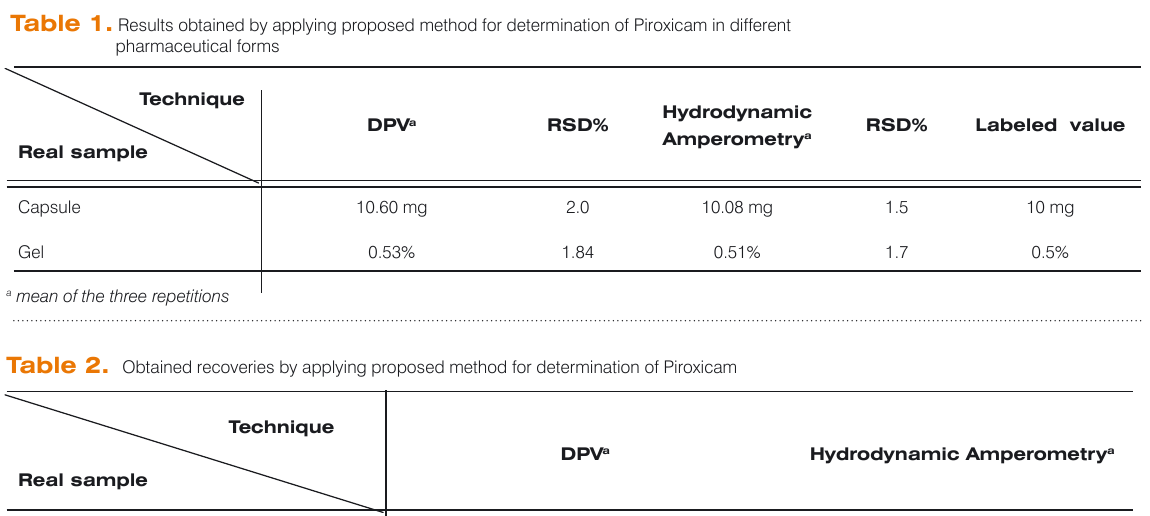
Table 1. Results obtained by applying proposed method for determination of Piroxicam in different pharmaceutical